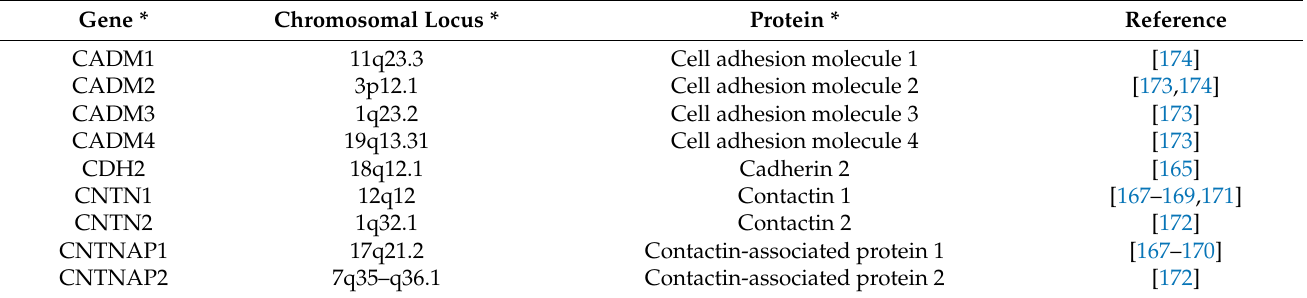
Table A2. Regulators of axoglial interactions in myelin